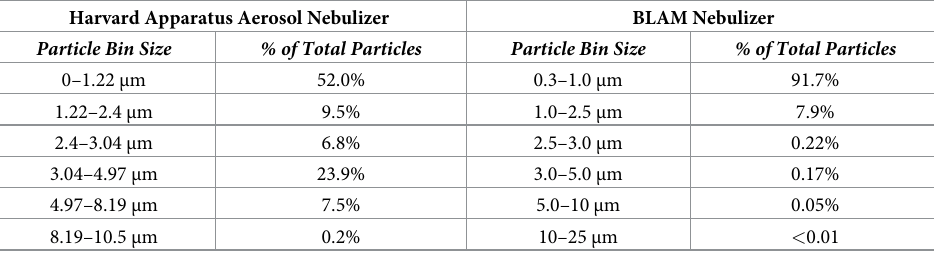
Table 3. Characterization of nebulizer aerosolized particle distribution.